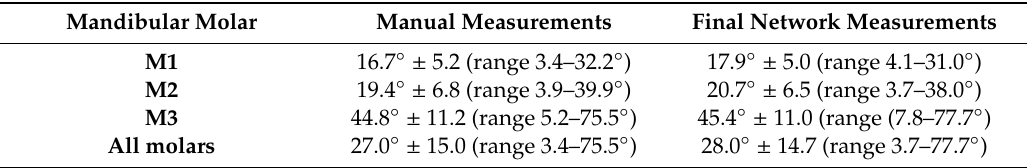
Table 2. Average angulations among 1500 mandibular molars on 250 panoramic images: human reference measurements vs. final network results. M1, M2, and M3 = first, second and third molar, respectively.